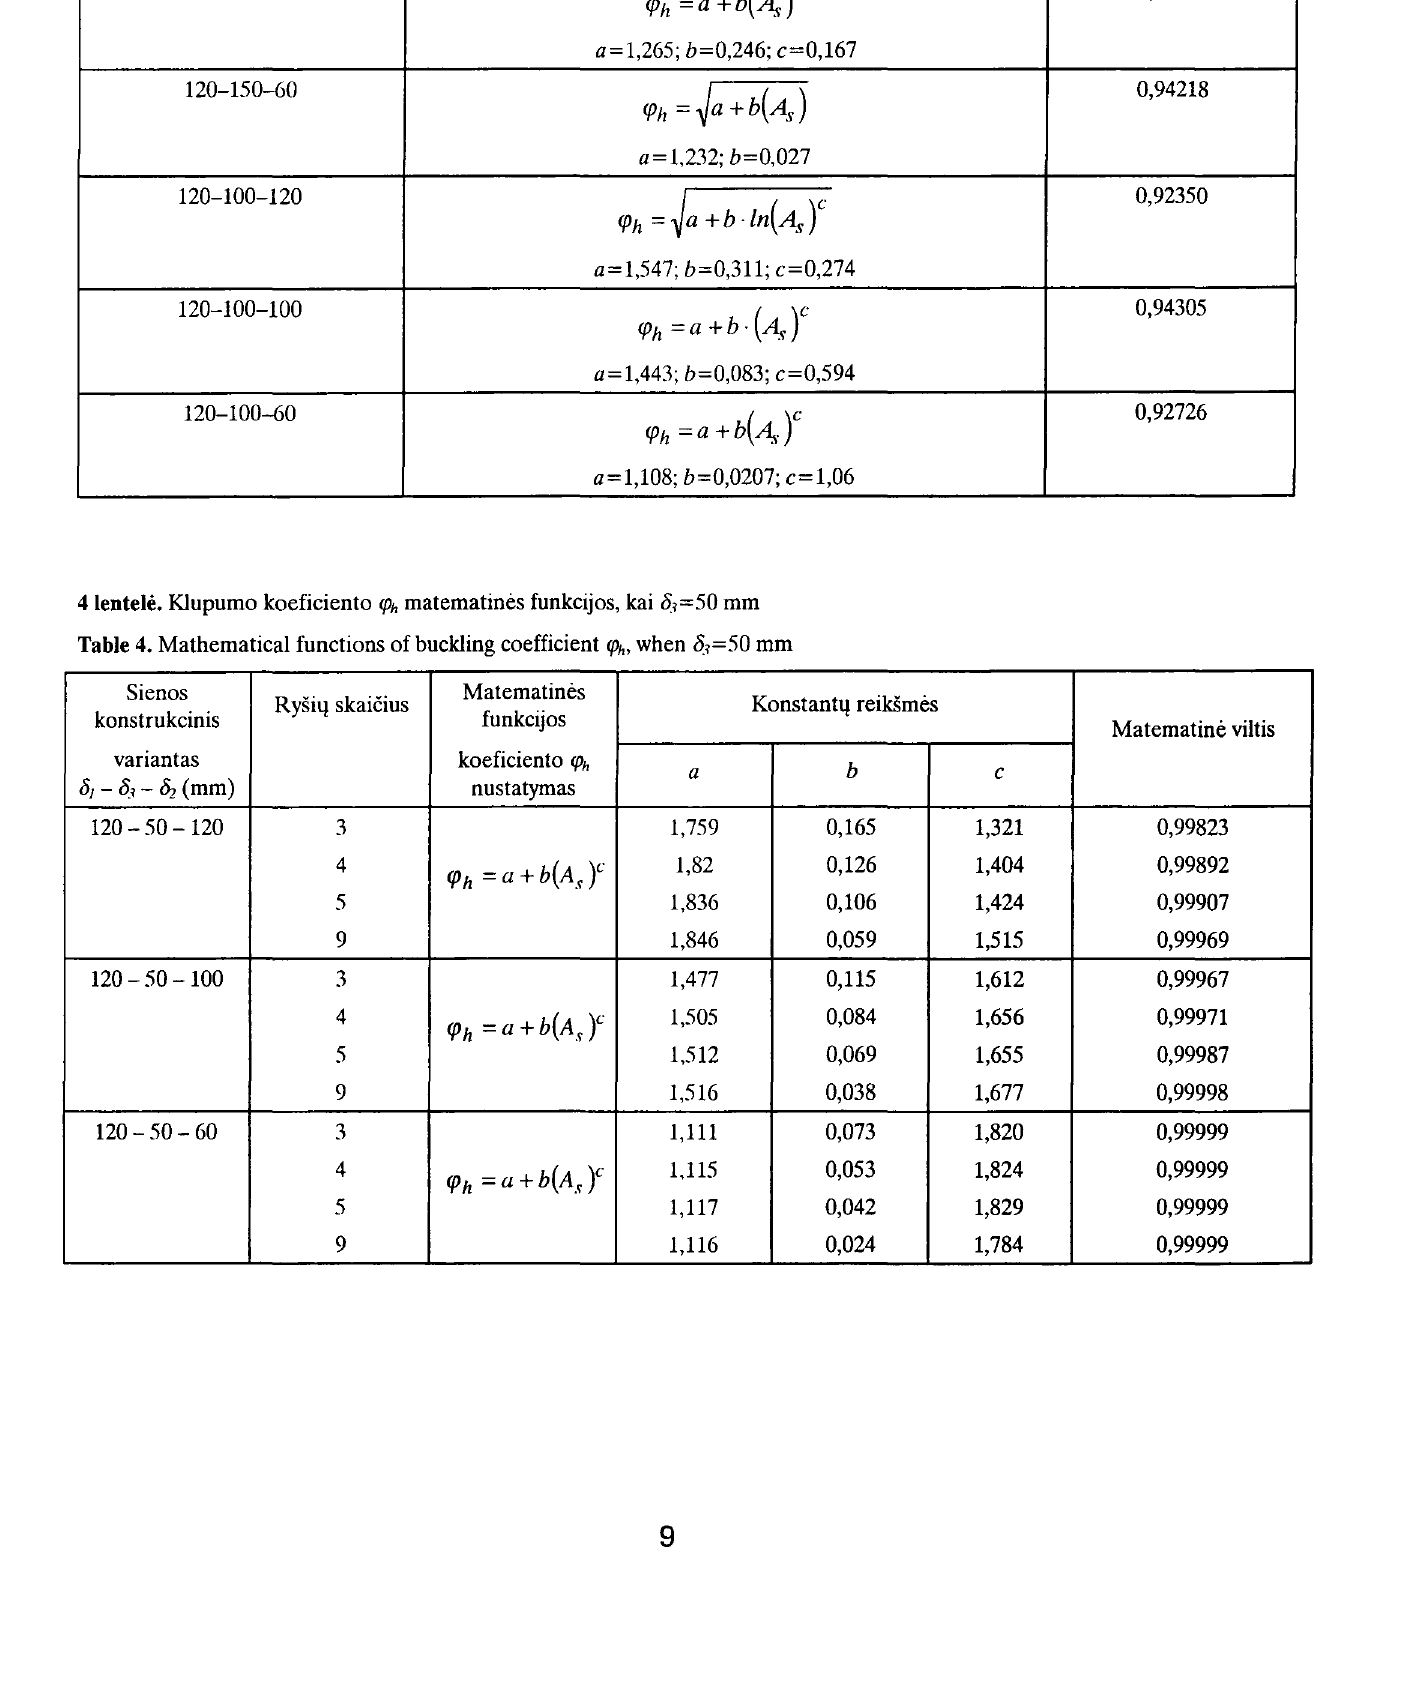
Table 4. Mathematical functions of buckling coefficient lfJh, when 8.1=50 mm Sienos